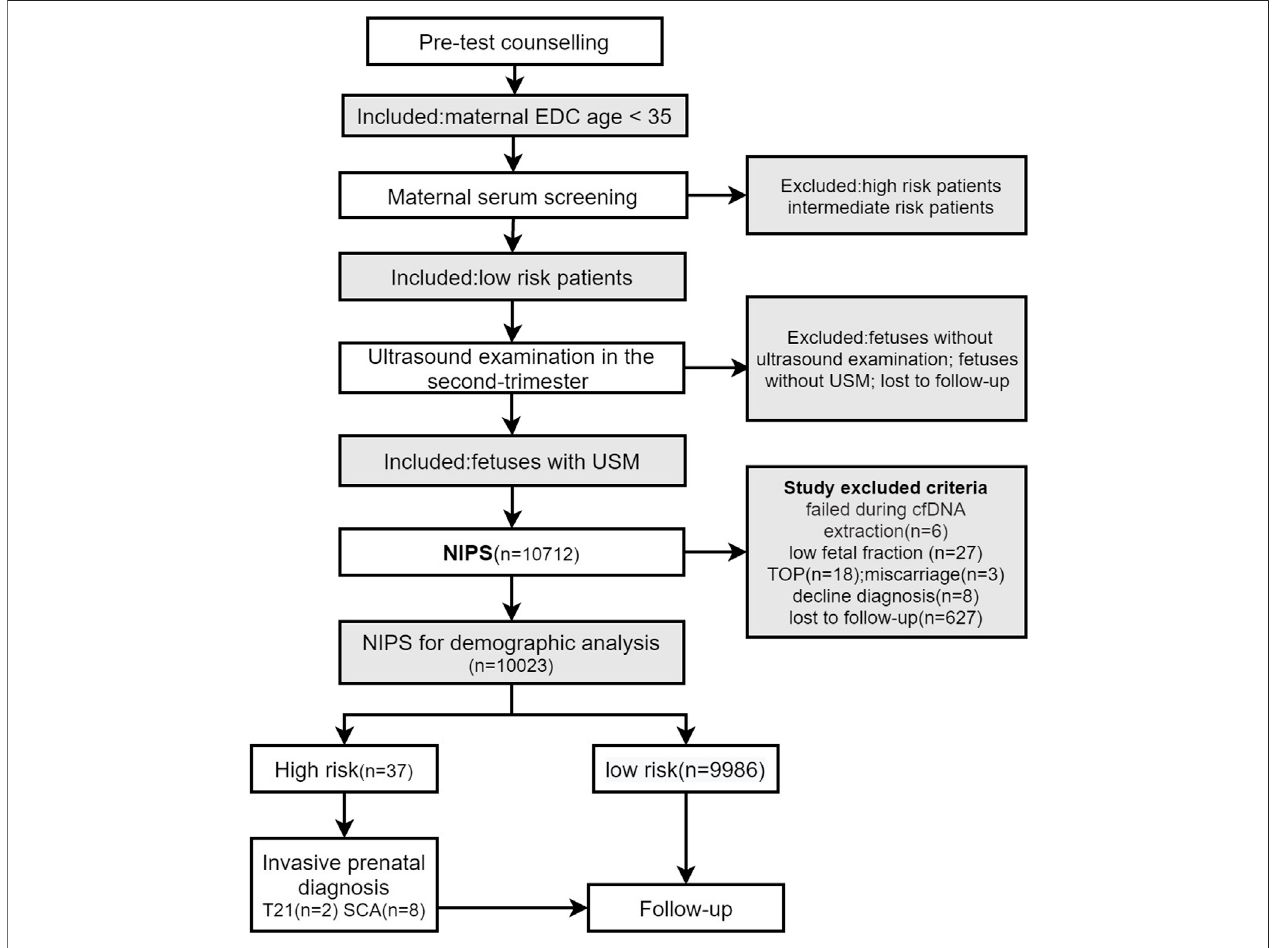
FIGURE 1 | EDC, expected date of con fi nement; USM, ultrasonographic soft markers; NIPS, noninvasive prenatal screening; TOP, termination of pregnancy.